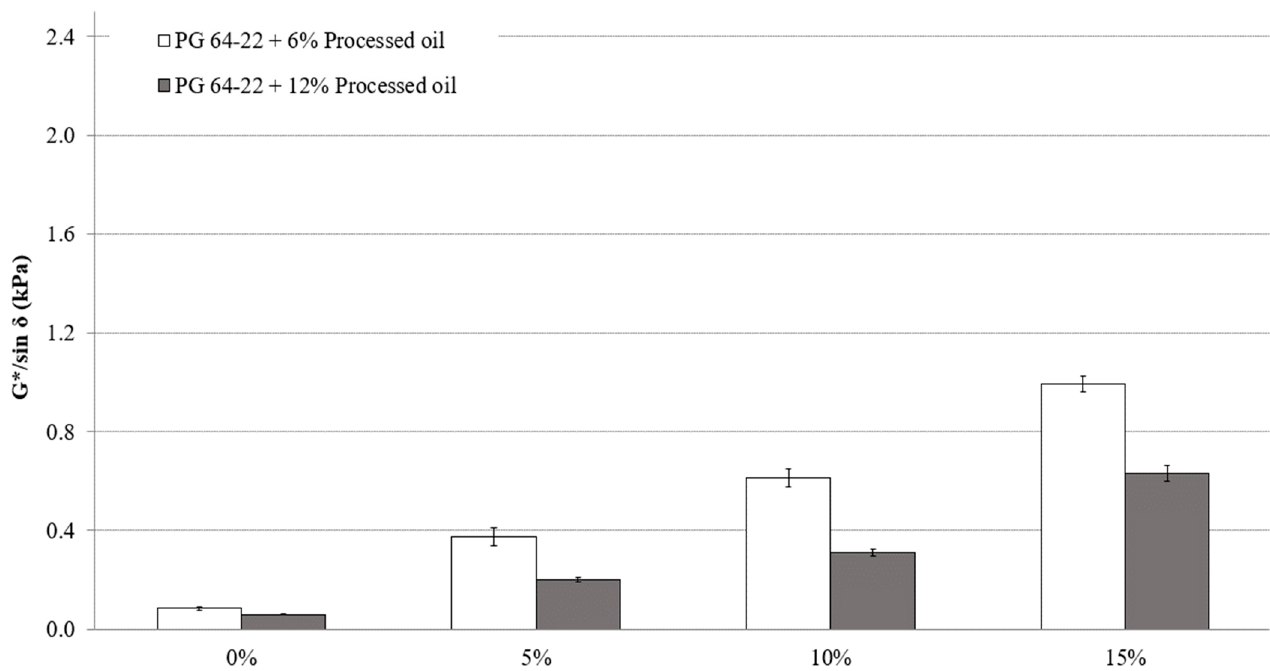
Figure 4. The relationship between the G*/sin δ of PG 64-22 binder containing processed oil, and the content of CRM at 82 °C.